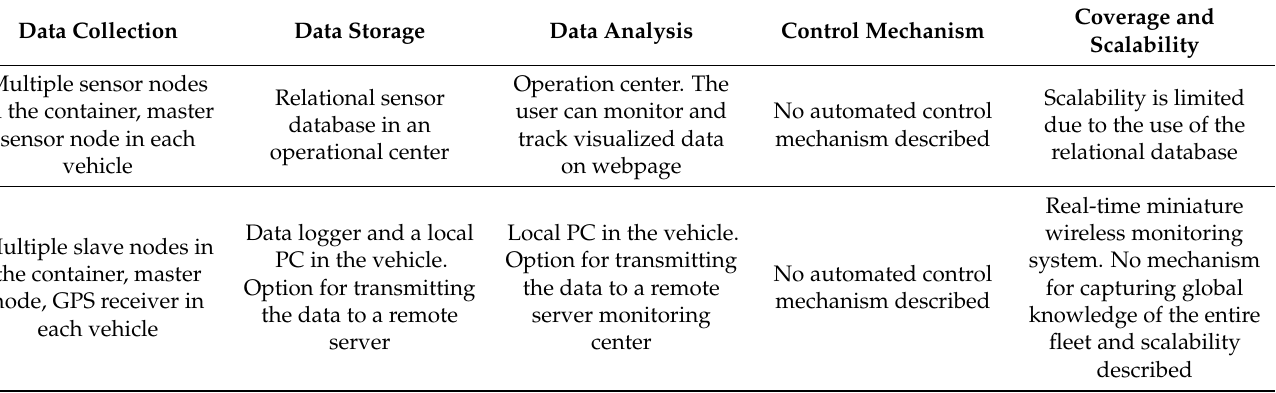
Table 1. Comparison of related works in the literature